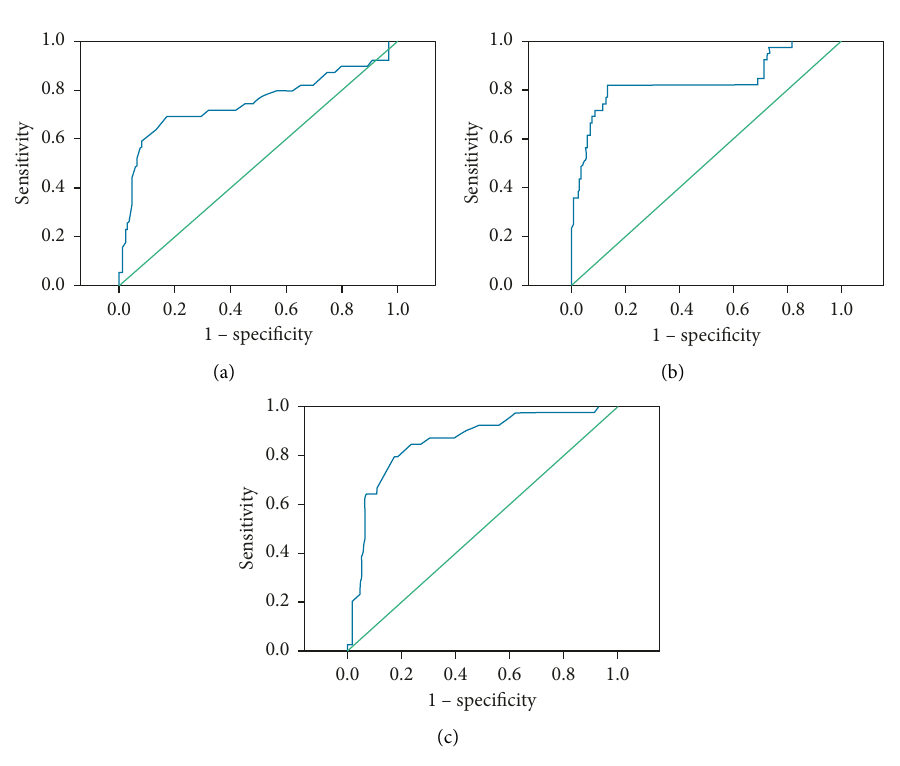
0.044. The optimal cutoff value ±